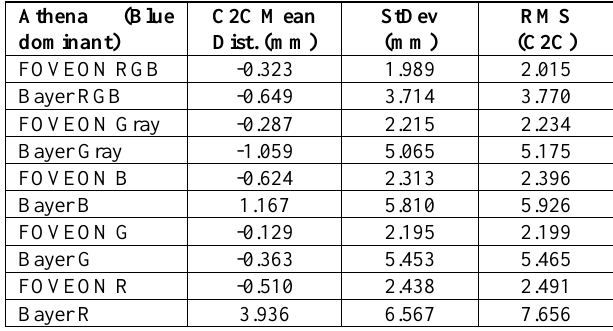
Table 4: Mean Distance, Standard Deviation and RMS error of every point cloud from the reference point cloud for Athena graffiti.